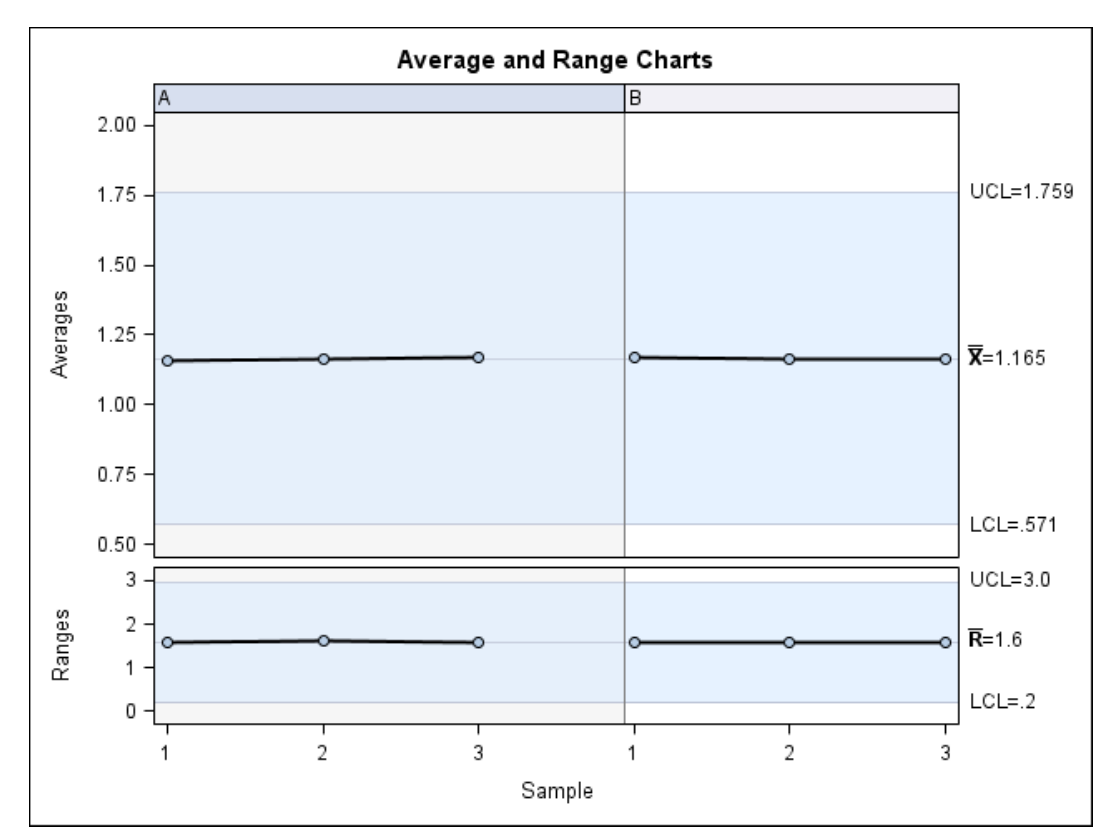
Figure 6. Charts of the average of the three measurements of the volumetric measurement (mm 3 ) of the palatine suture expansion after RME procedures through McNamara appliance. Left column (A) is referred to Operator 1 and right column (B) is referred to Operator 2.